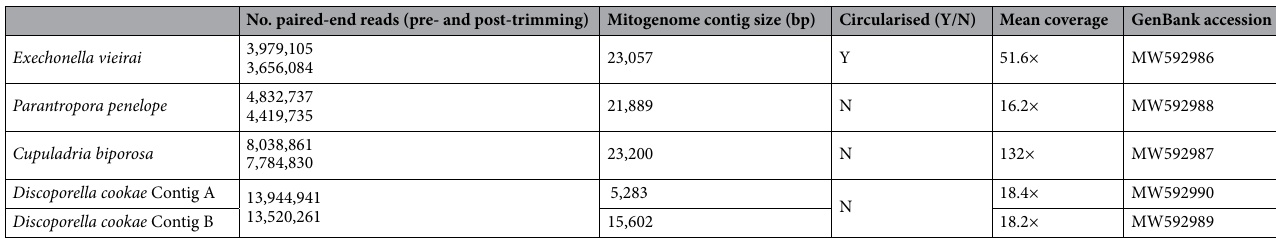
Table 1. Number of raw Illumina reads, mitogenome contig sizes, coverage depth and GenBank accession numbers for Exechonella vieirai , Parantropora penelope, Cupuladria biporosa and Discoporella cookae